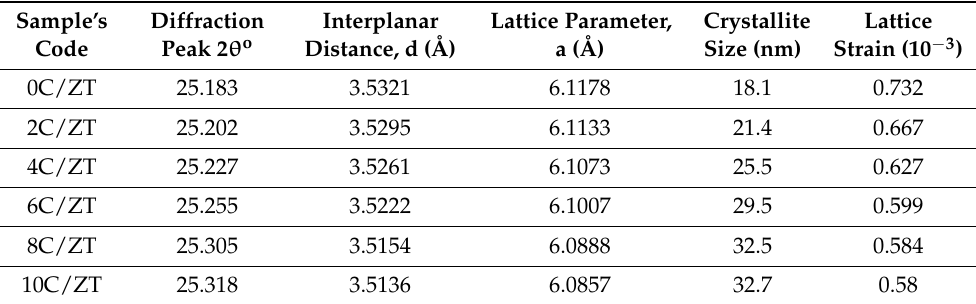
Table 2. Crystallographic parameters of ZnTe and the ZnTe:Cu thin